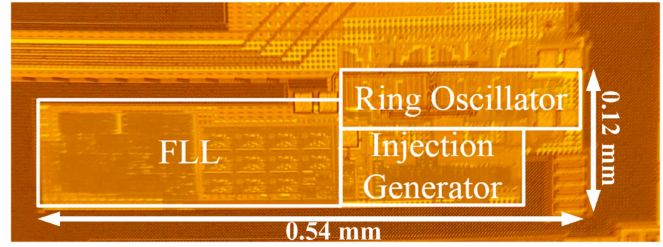
Figure 9. Chip microphotograph of ILFM.